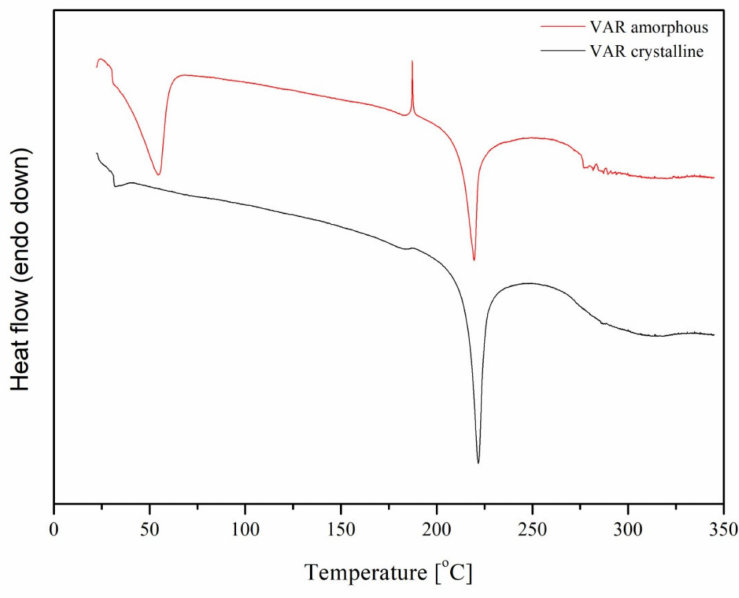
Figure 2. Differential scanning calorimetry (DSC) of crystalline and amorphous